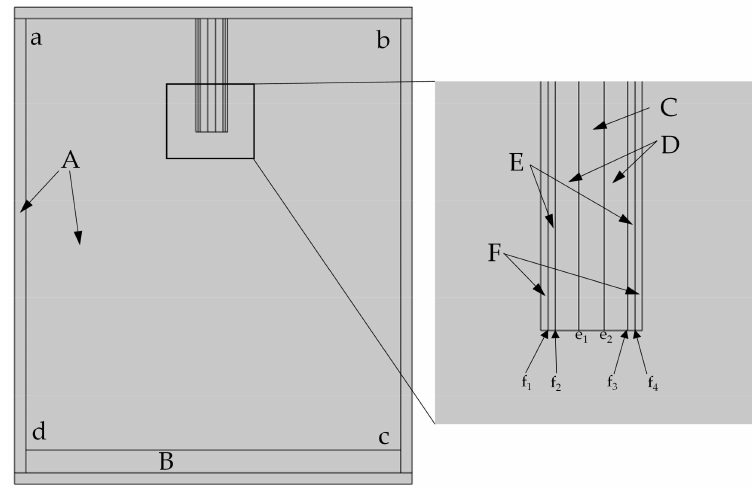
Figure 3. Simulation model. Table 1. Simulation model zones and their material properties. Regional Division Material